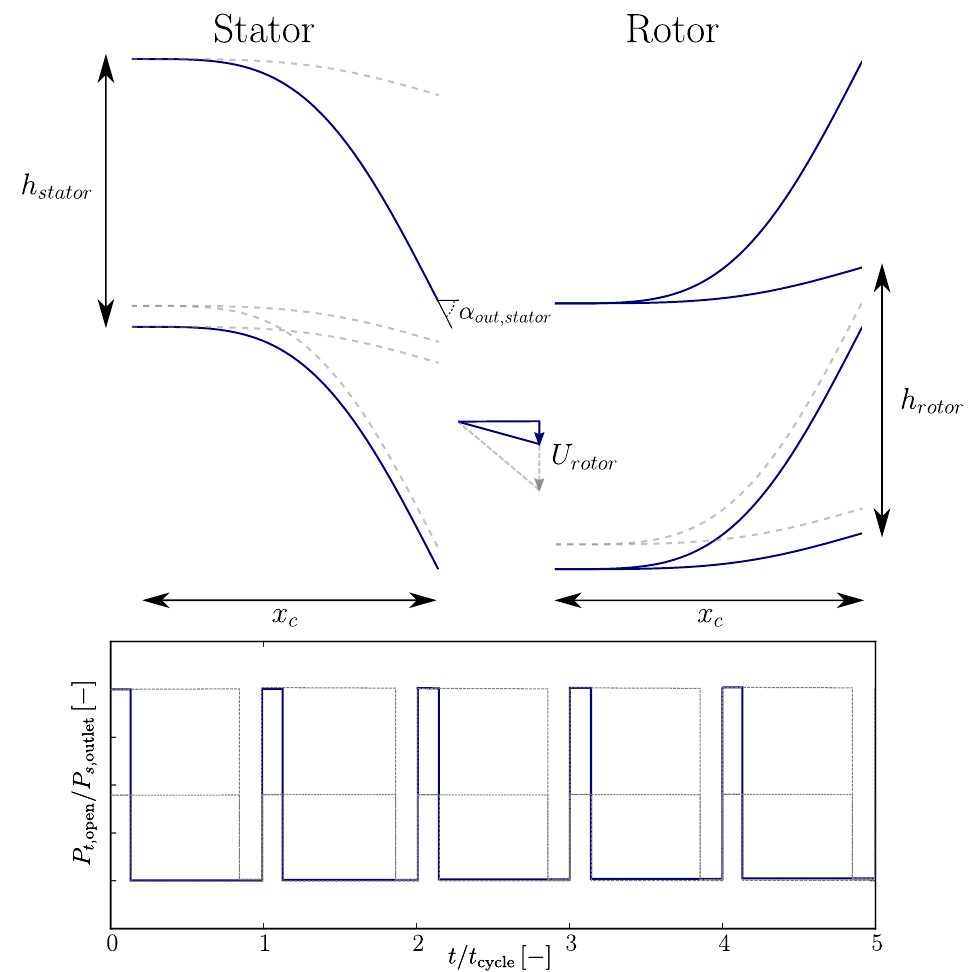
Figure 5. Design recommendation for a turbine driven by a pulsed flow. Recommendations are identified by blue lines. The gray dashed lines show the experimental domain. It should be noted that the speed triangle shown is a pictorial, albeit very inadequate, way of characterizing the rotor speed in relation to a semblance of flow